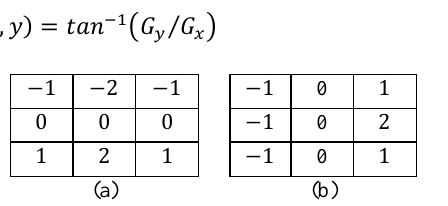
Figure3. Sobel masks, (a) horizontal mask and (b) vertical mask.